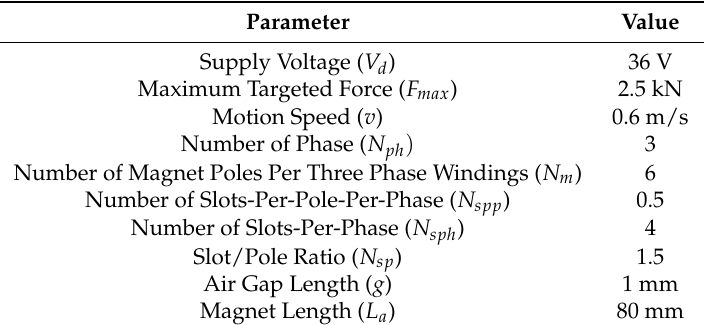
Table 1. Initial design